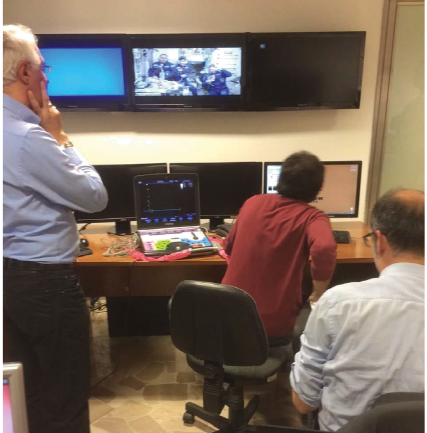
Figure 2: Mission control guiding the astronaut Cristoforetti and the other crewmembers to use the Vivid q CU device during the space mission Futura onboard of the International Space Station.